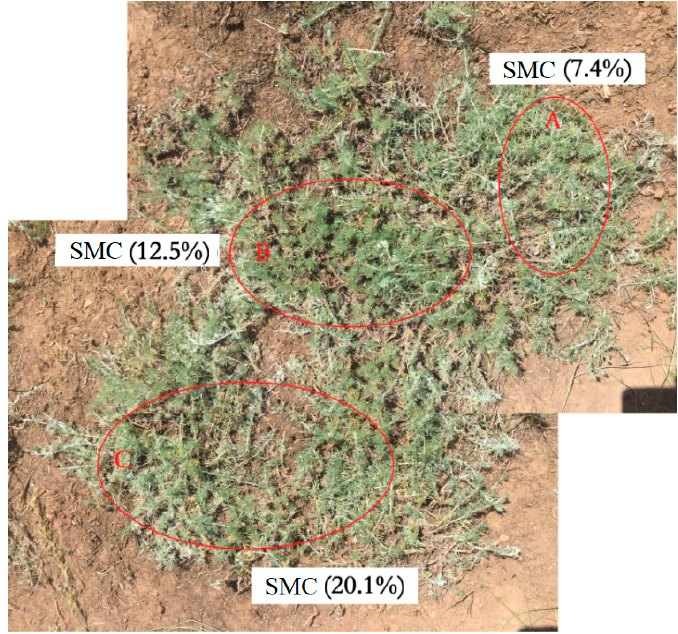
Figure 12. Observation experiment of Artemisia frigida with different SMCs.